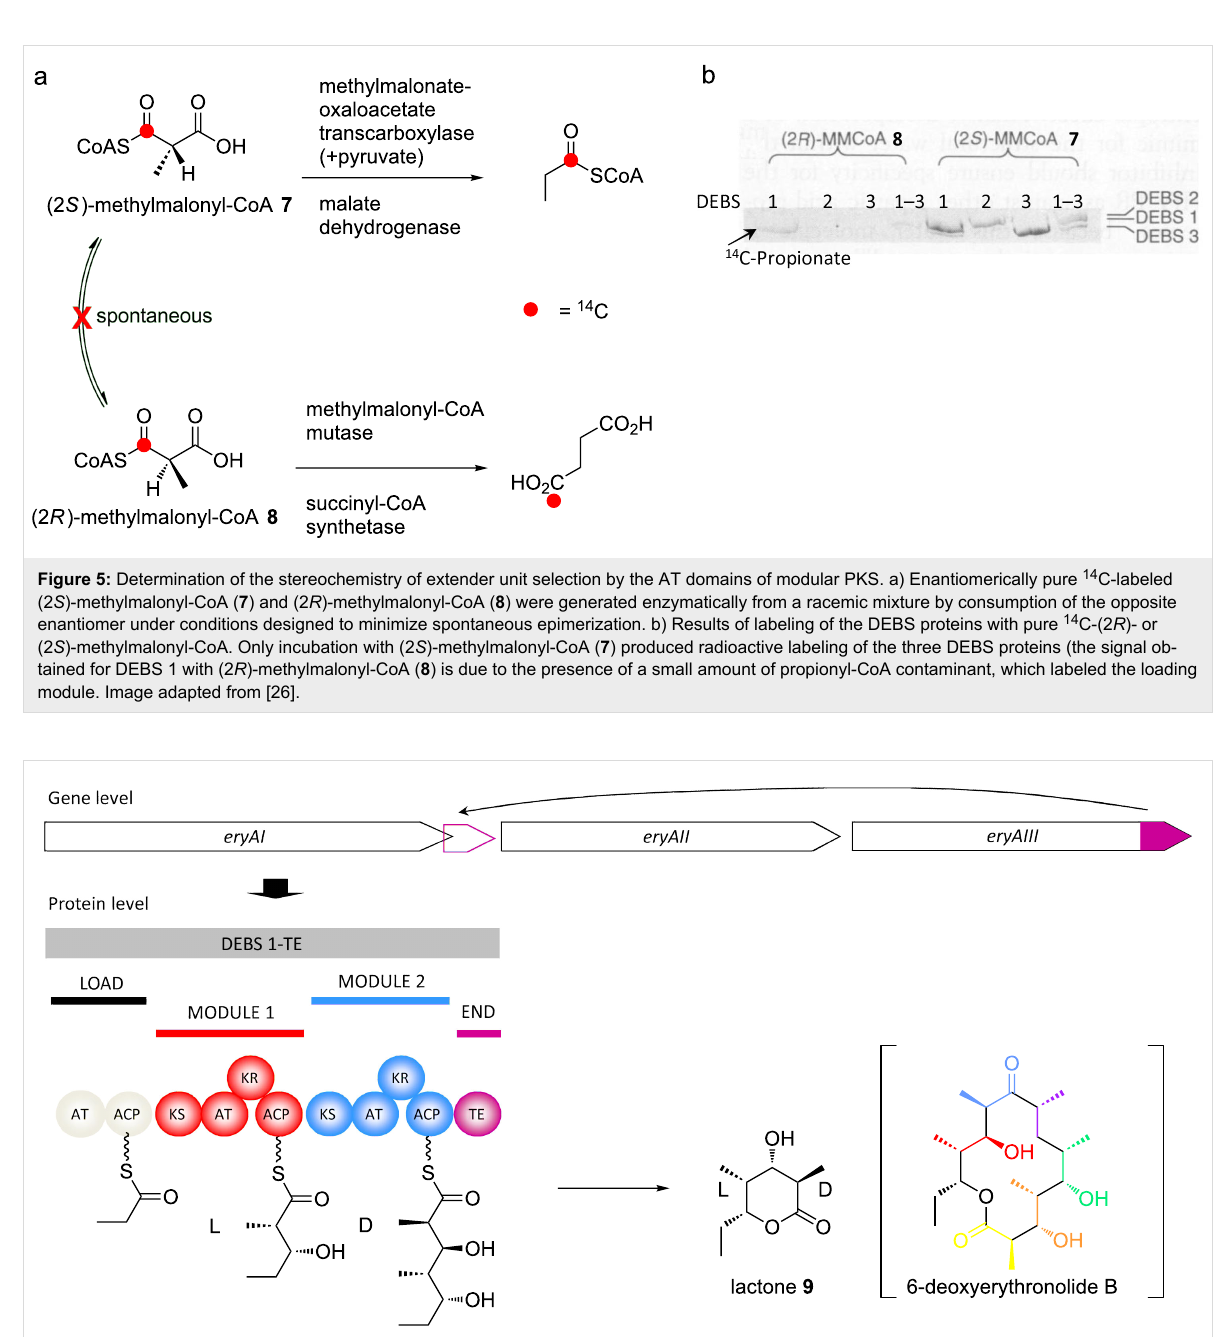
polyketide at the triketide stage. This modification results in an experimentally tractable δ -lactone 9 instead of the 14-mem- bered macrolide, 6-deoxyerythronolide B. Notably, the two methyl centers in the lactone have opposite configurations (for clarity, that at C-2 will be referred to as D-configured, and that at C-4 as L), and thus DEBS 1-TE represented an ideal system